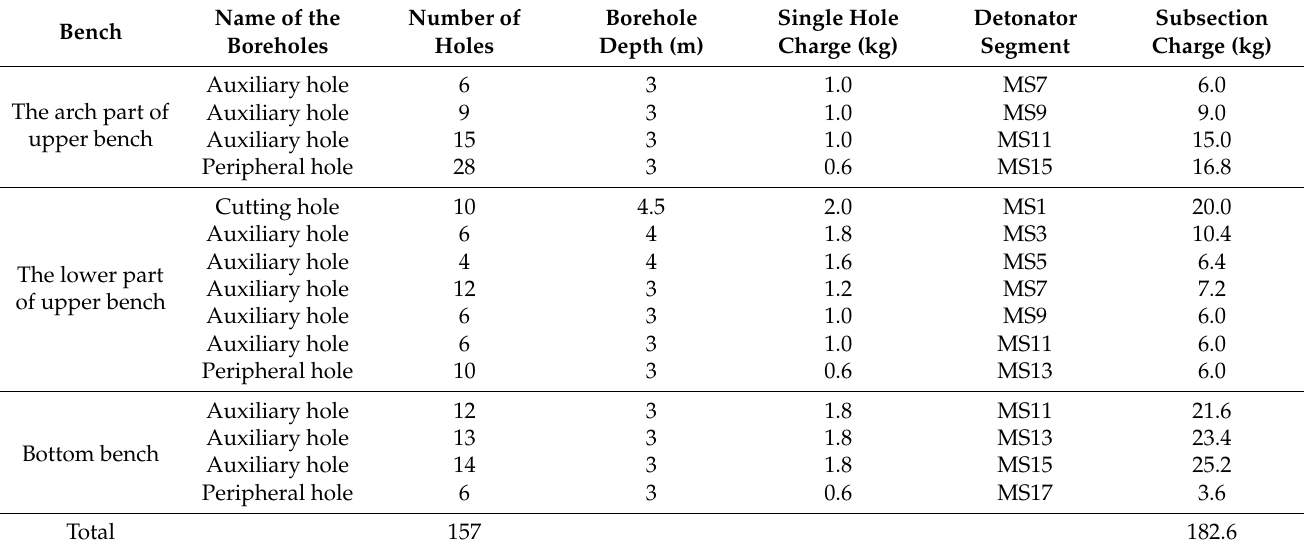
Figure 1. The hole arrangement and initiation sequence of nonelectric detonator blasting in the test. Note: The marked MS represents the detonator delay time series. The holes connected by dotted lines are in the same delay sequence and represent simultaneous initiation. Table 2. Details of blasting holes and explosive parameters.